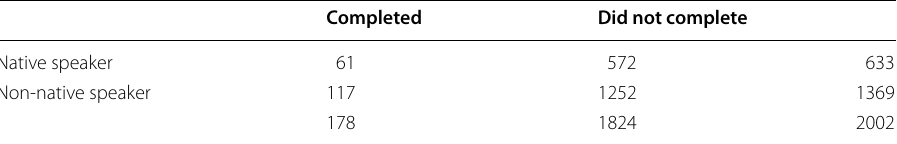
Table 2 Contingency table of “Structural materials: selection and economics”, third trimester, 2017, successful completion by language Completed Did not complete Native speaker 61 572 633 Non‑native speaker 117 1252 1369 178 1824